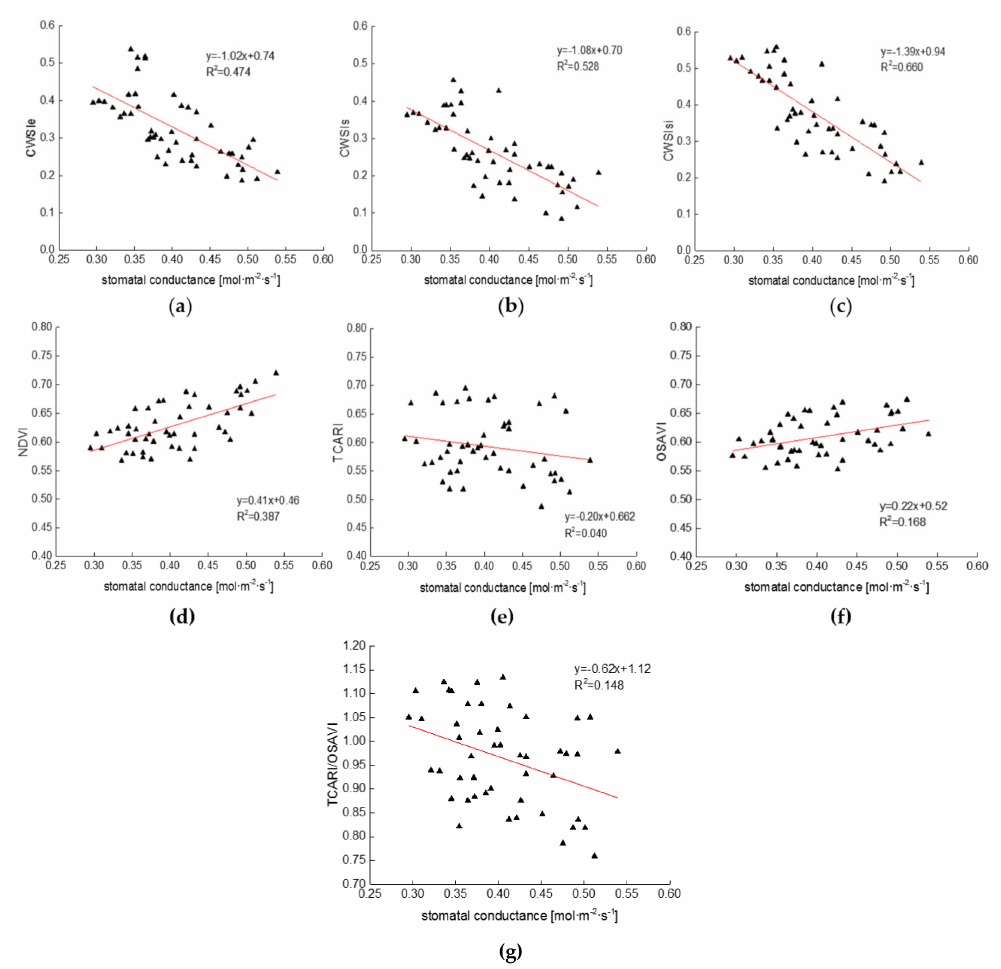
Figure 6. Relationship between stomatal conductance and ( a ) empirical CWSI (CWSIe), ( b ) statistical CWSI (CWSIs), ( c ) simplified CWSI (CWSIsi), ( d ) normalized difference vegetation index (NDVI), ( e ) transformed chlorophyll absorption in reflectance Index (TCARI), ( f ) optimized soil-adjusted vegetation index (OSAVI), ( g ) TCARI/OSAVI. Note: four days of data at plot level, n =